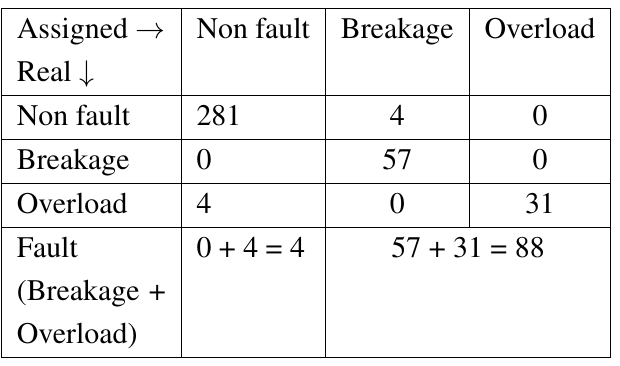
Table 3. Confusion Matrix of Bayesian